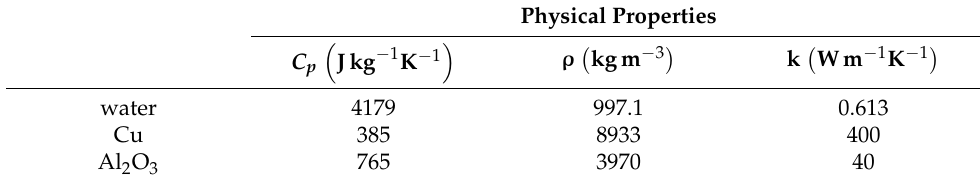
Table 2. Thermo physical properties (Oztop and Abu-Nada